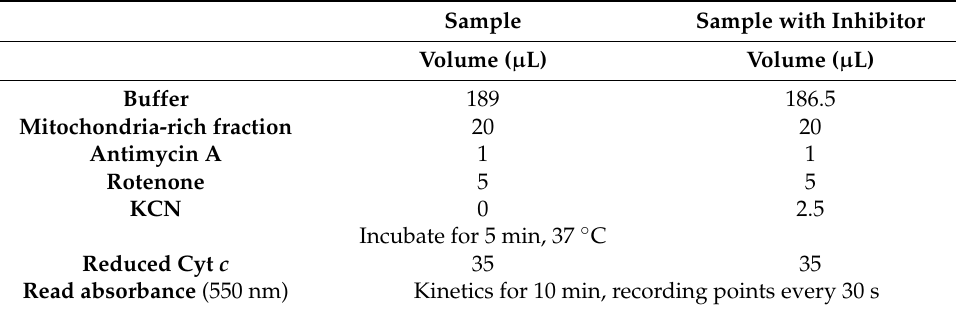
Table 7. Conditions and flow setup for Complex IV activity